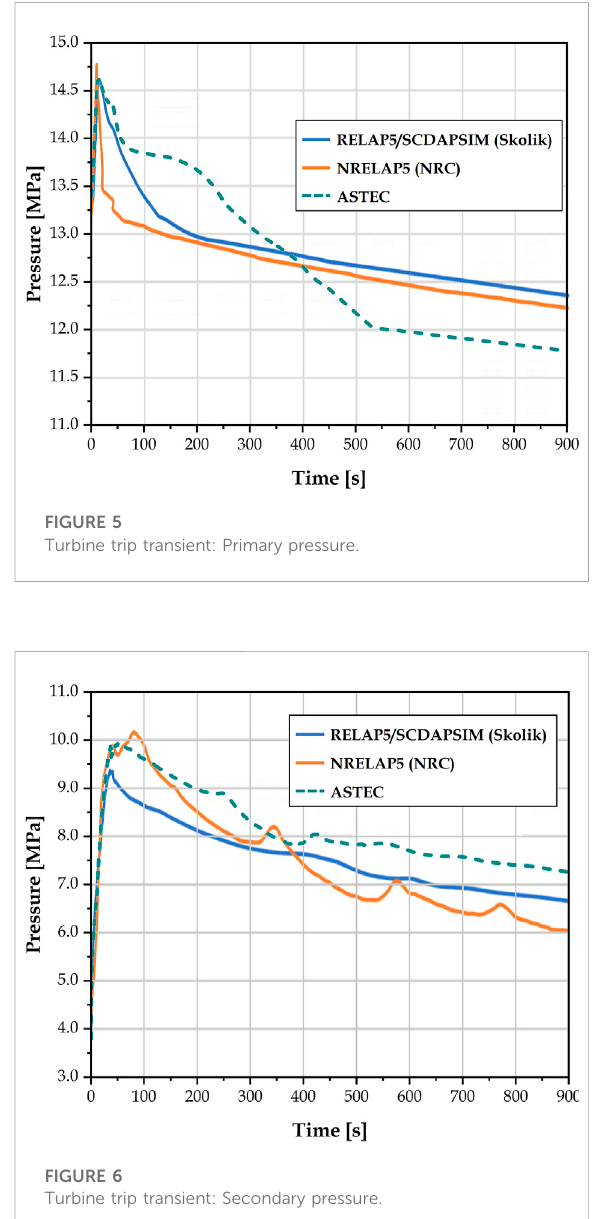
FIGURE 8 Turbine trip transient: Pressurizer water